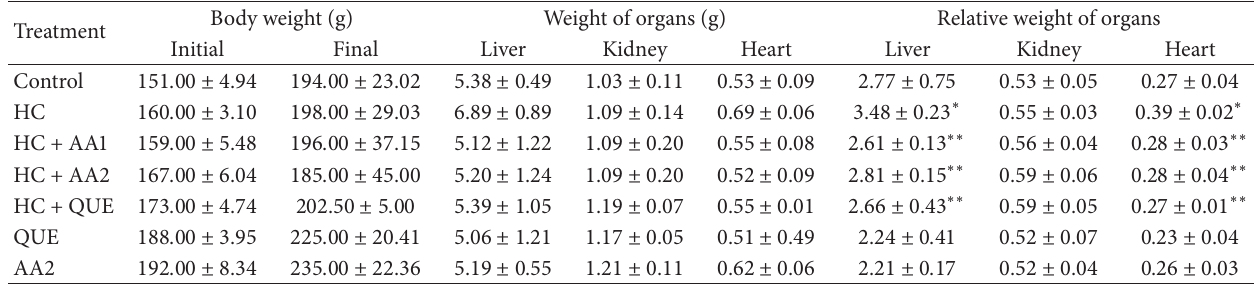
Table 1: Changes in the body weight and relative weight of organs of hypercholesterolemic rats treated with methanol extract of Artocarpus altilis for nine